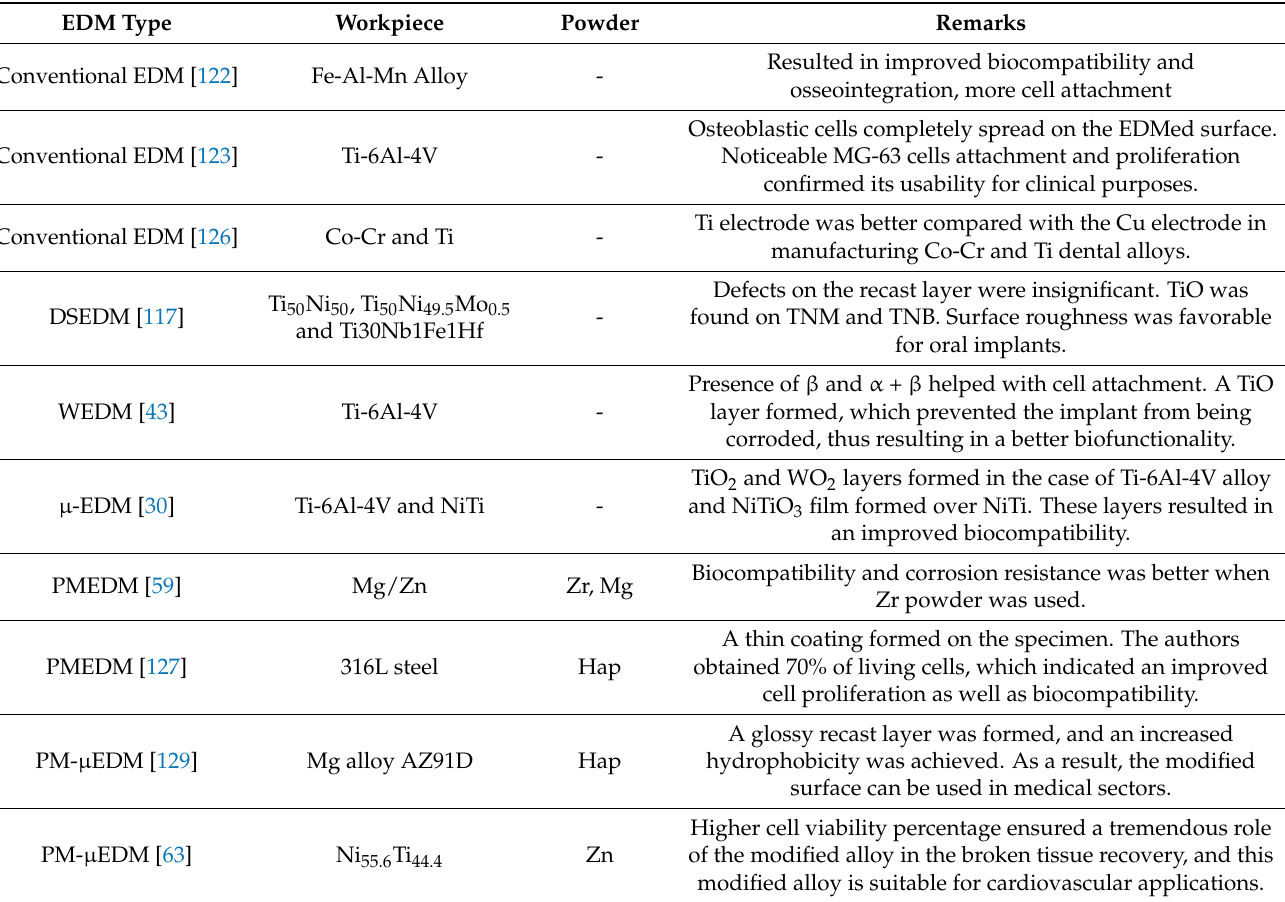
Table 2. Recent works conducted in the biomedical sector using EDM